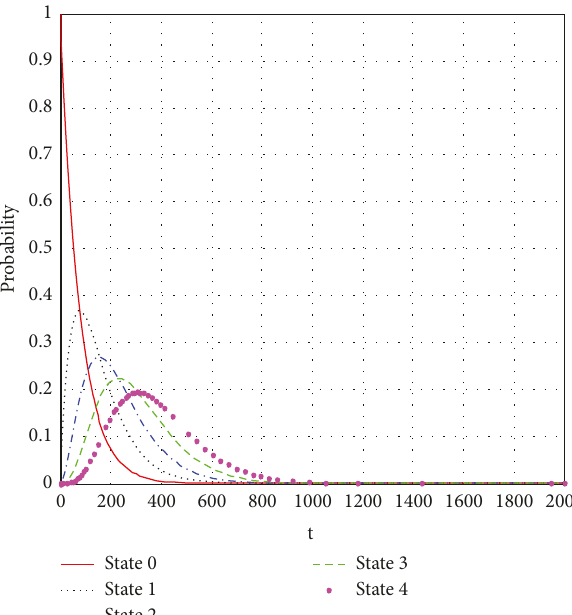
Figure 12: Probability curves in different states.